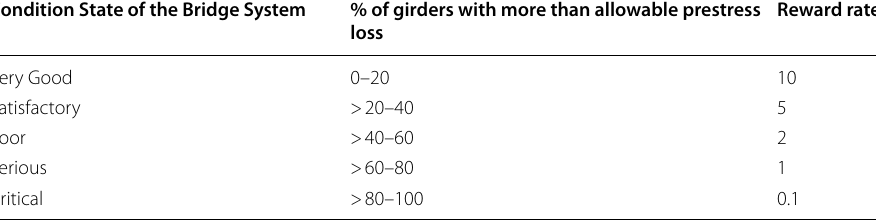
Table 1 Reward structure